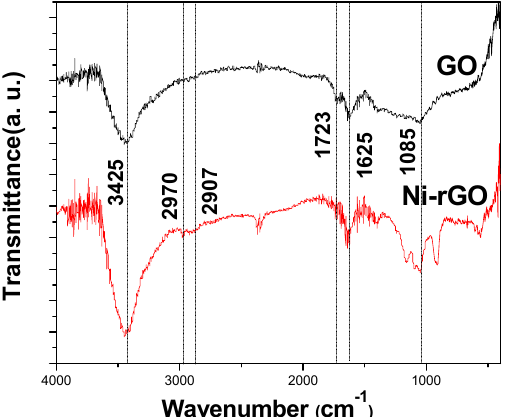
Figure 2. FT-IR spectra of the as-prepared GO and Ni-rGO